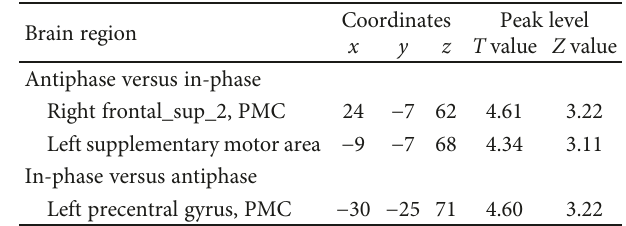
Table 3: Brain areas more activated in performing antiphase bimanual movements than in performing in-phase bimanual movements in the normal subject group. Results were thresholded at P < 0 001 and